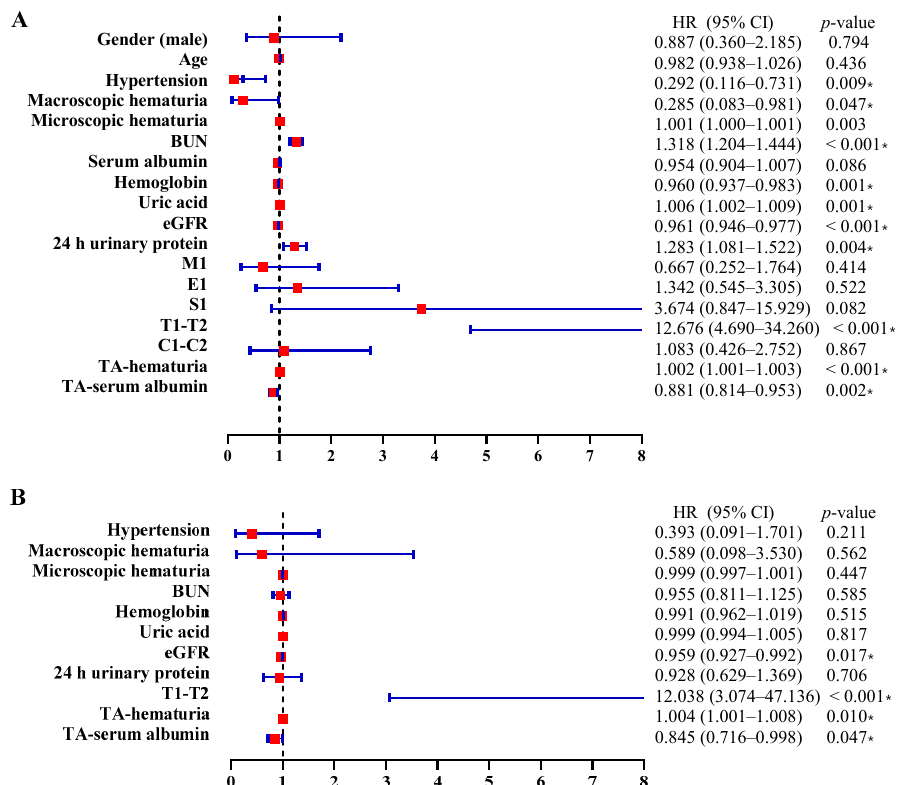
Figure 4. Risk factors for the renal outcome determined by ( A ) univariate or ( B ) multivariate Cox hazard analysis in IgAN. CI, confidence interval; HR, hazard ratio; BUN, blood urea nitrogen; TC, total cholesterol; TG, triglycerides; eGFR, estimated glomerular filtration rate; M1, mesangial hypercellularity; E1, endocapillary hypercellularity; S1, segmental glomerulosclerosis; T1–T2, tubular atrophy/interstitial fibrosis > 25%; C1–C2, presence of crescent; TA, time-averaged. * Two-tailed p < 0.05.